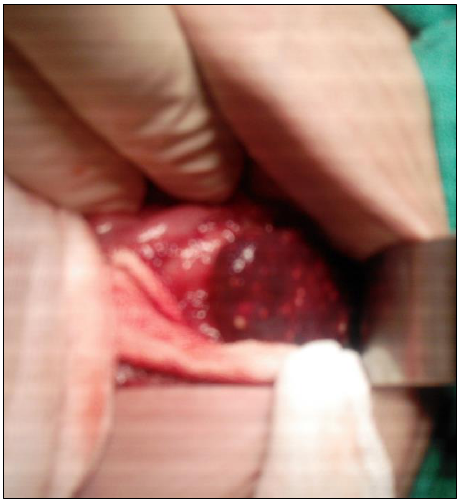
Figure 1: Multiple abscesses in